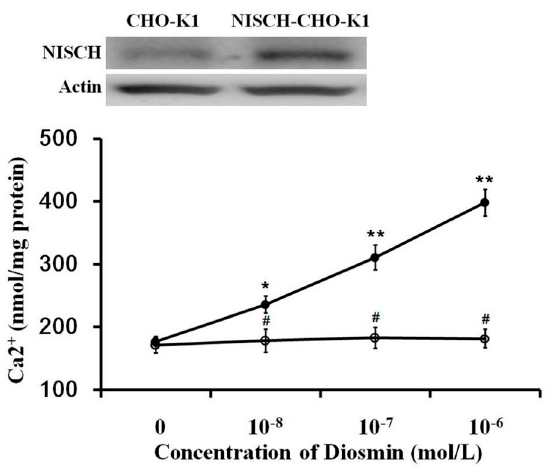
Figure 2. Direct effect of diosmin on imidazoline receptors (I-R) in Chinese hamster ovary (CHO-K1) cells. Successful transfection of CHO-K1 cells with the I-R gene (NISCH) is confirmed with Western blots in the upper figure. There is a dose-dependent elevation in calcium content by diosmin in NISCH-transfected CHO-K1 cells (NISCH-CHO-K1 Cells) compared with cells transfected with empty vector (CHO-K1 Cells). The values are presented as mean ± SEM ( n = 8). * p < 0.05 and ** p < 0.01 vs. the vehicle-treated group (0 mol/L). # p < 0.05. vs. the values of NISCH-CHO-K1 Cells.